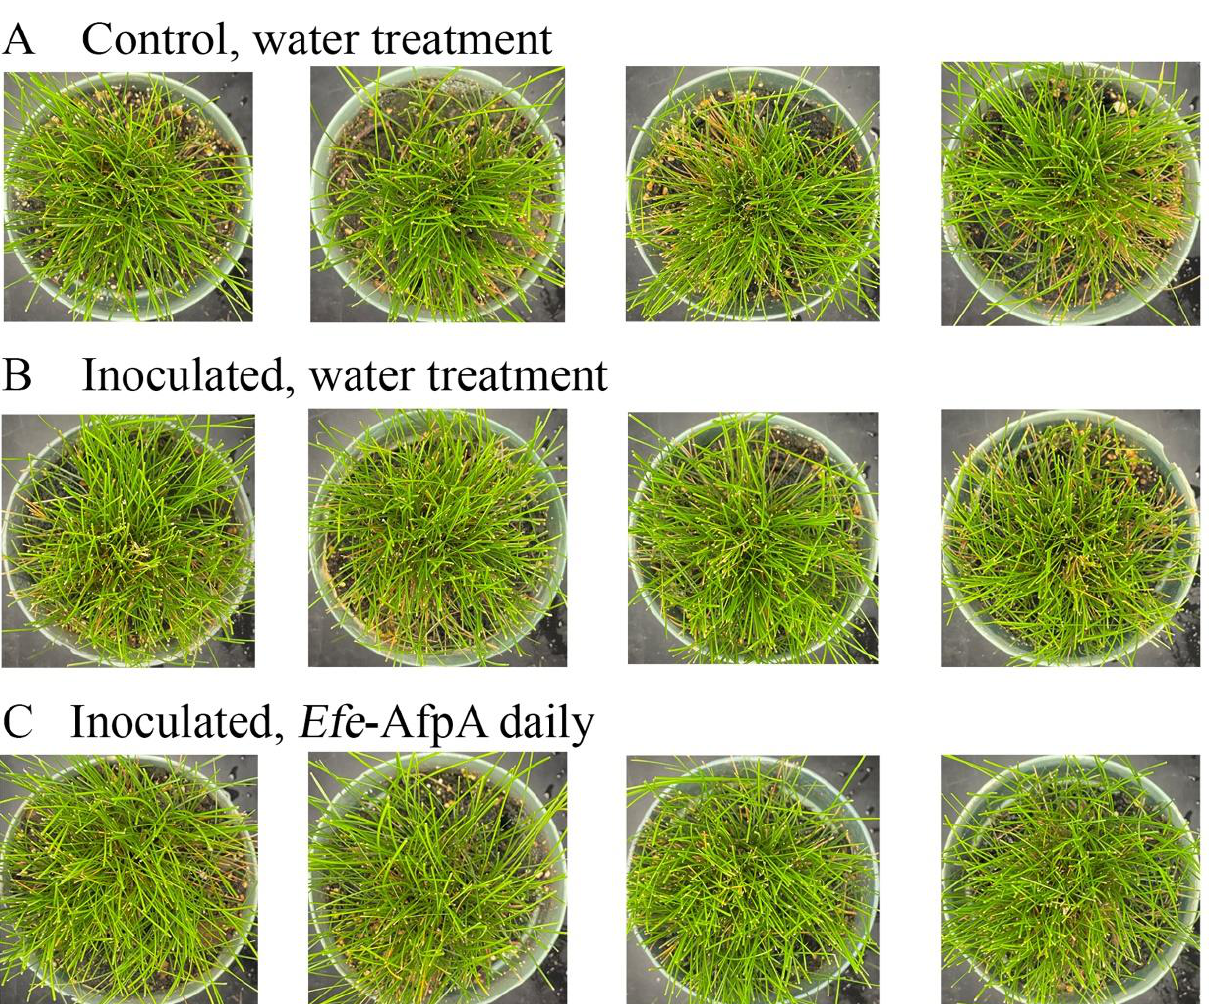
Figure 8. Endophyte infected strong creeping red fescue plants exhibited no dollar spot disease symptoms when inoculated with an 8 mm plug of C. jacksonii . Plants were sprayed daily for 10 days with either water ( A , B ) or 100 µ g mL − 1 of Efe -AfpA ( C ). Photos within a row are replicates of the labeled treatment.